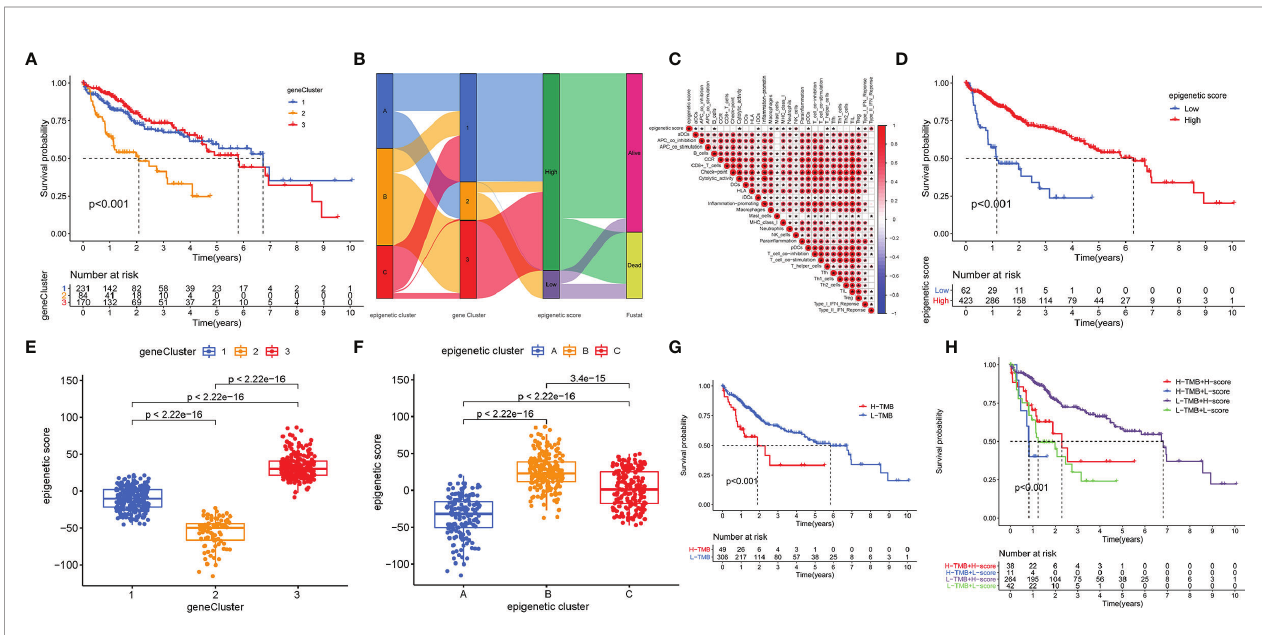
FIGURE 4 | Construction of epigenetic scores; functional annotation and the relationship between the epigenetic score, epigenetic cluster and gene cluster. (A) Gene cluster 2 had a poor prognosis; (B) The ggalluvial diagram displaying relationships among epigenetic score, epigenetic cluster and gene cluster; (C) Correlations among in fi ltrating-cell types and epigenetic score; (D) The performance of epigenetic score in predicting patients ’ prognosis. Patients with low epigenetic scores showed poor survival outcome; (E) Differences in epigenetic scores among epigenetic gene clusters as determined using the Kruskal-Wallis test; (F) Differences in epigenetic scores among the epigenetic clusters as revealed by Kruskal-Wallis test; (G) High TMB group had poor prognosis; (H) The survival results predicted by the combination of TMB and epigenetic score. * indicate P <